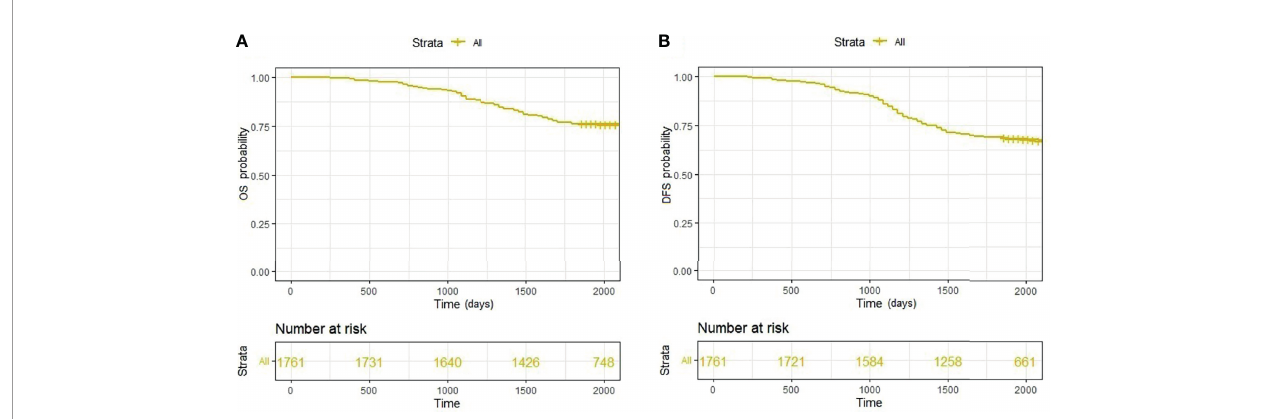
FIGURE 2 | (A) Overall survival of all patients; (B) Disease-free survival of